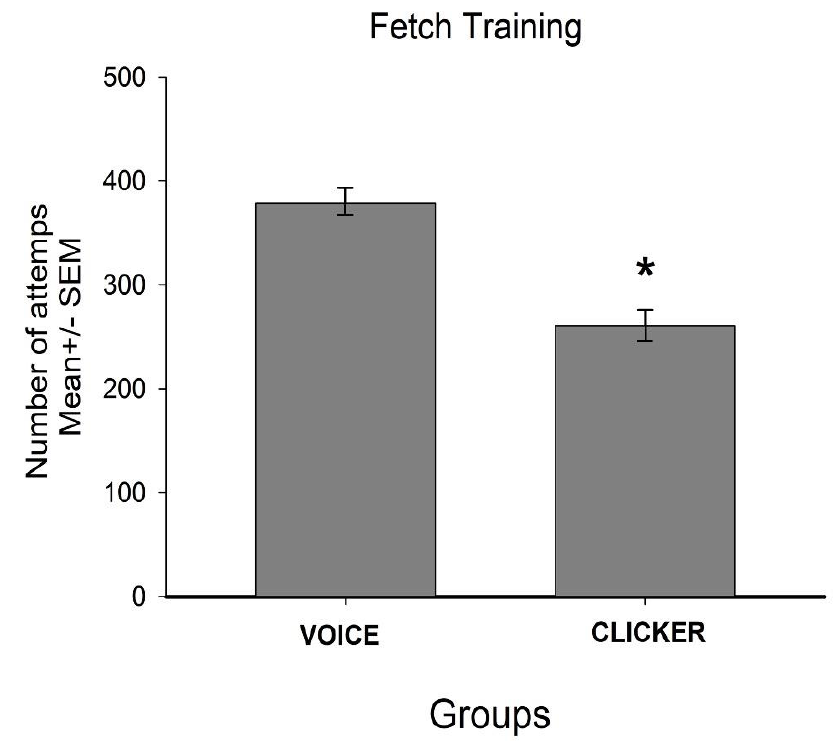
Figure 2. Animals from the clicker group required fewer repetitions to learn to fetch an object than those trained with voice. * indicates p < 0.05.